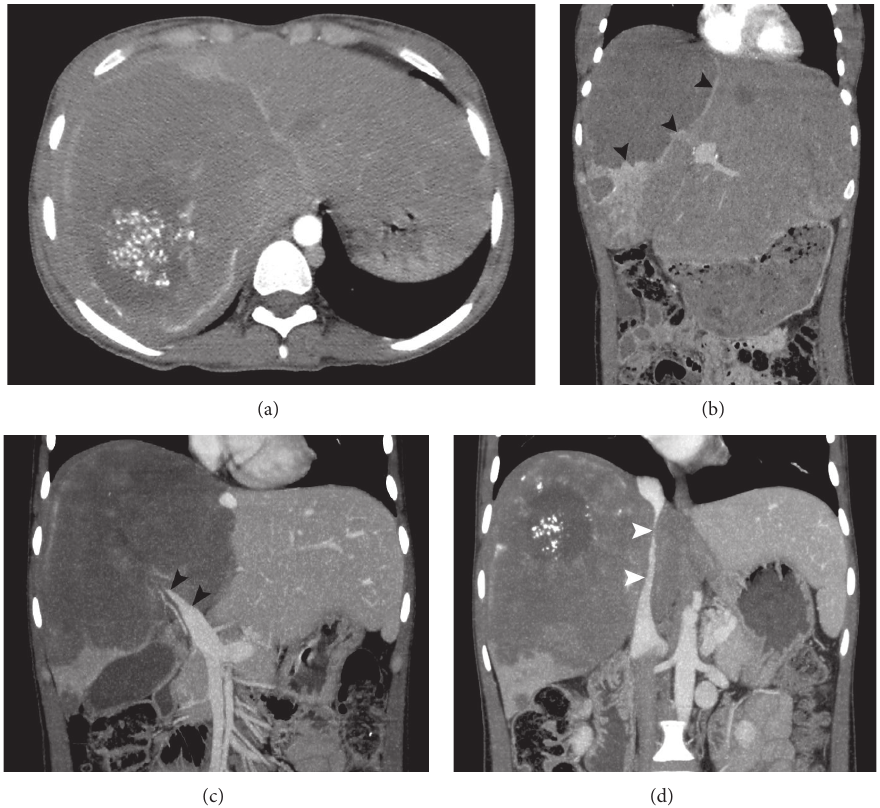
Figure 4: Axial enhanced abdominal CT image (a) demonstrates an infiltrative tumor-like hepatic lesion with irregular margins and heterogeneous contents, including amorphous calcifications. The fibroinflammatory tissue surrounding the mass (arrowheads) exhibits mild contrast enhancement in a delayed phase coronal reformatted CT image (b). Right portal vein branch thrombosis (arrowheads) is shown in acoronal contrast-enhanced maximum intensity projection (MIP) image (c). Another coronal MIP image (d) depicts severe narrowing of the intrahepatic vena cava inferior